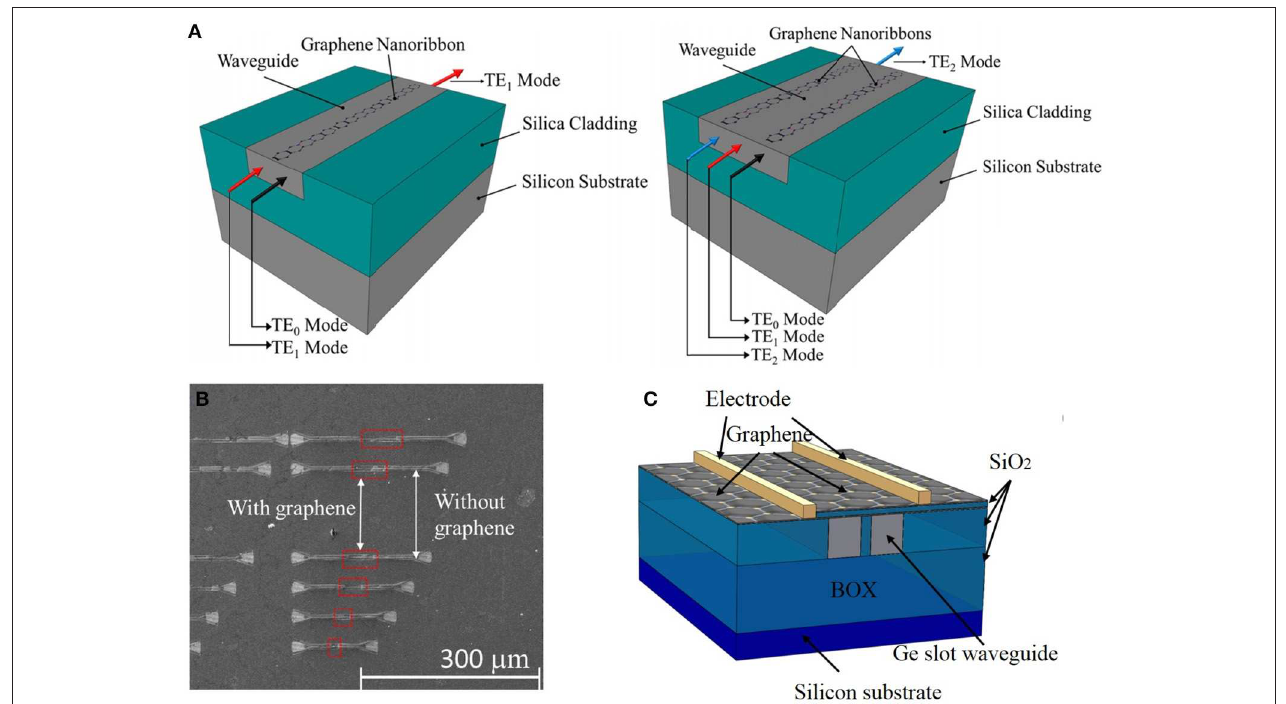
FIGURE 2 | Waveguide-integrated graphene photonic devices. (A) Schematic of the waveguide-integrated graphene TE 1 -mode-pass and TE 2 -mode-pass filters. (B) SEM image of the graphene-on-silicon slot waveguide saturable absorber. (C) Schematic of the dual-layer graphene-on-Ge slot waveguide modulator. A is reprinted with permission from Ref. [ 36]. Copyright © 2019 Optical Society of America. B is reprinted with permission from Ref. [15]. Copyright © 2019 IOP Publishing. C is reprinted with permission from Ref. [ 37]. Copyright © 2019 Optical Society of